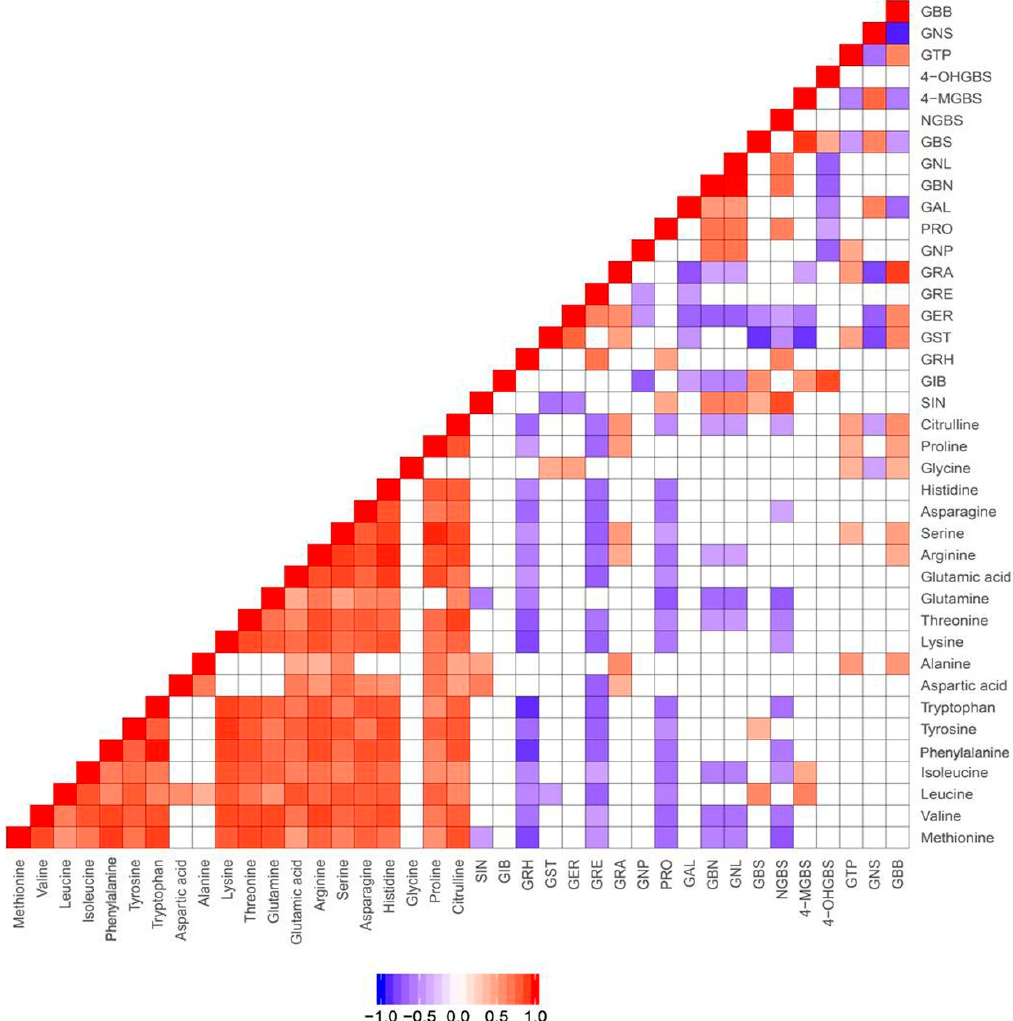
Figure 1. Correlations between metabolites in 5 vegetables confirmed by targeted quantitative analysis of amino acids, glucosinolates. SIN, sinigrin; GIB, glucoiberin; GRH, glucoraphasatin; GST, Glucosativin; GER, glucoerucin; GRE, glucoraphenin; GRA, glucoraphanin; GNP, gluconapin; PRO, progoitrin; GAL, glucoalyssin; GBN, glucobrassicanapin; GNL, gluconapoleiferin; GBS, glucobrassicin; NGBS, neoglucobrassicin; 4-MGBS, 4-methoxyglucobrassicin; 4-OHGBS, 4-hydroxyglucobrassicin; GTP, glucotropaeolin; GNS, gluconasturtiin; GBB, glucobarbarin .